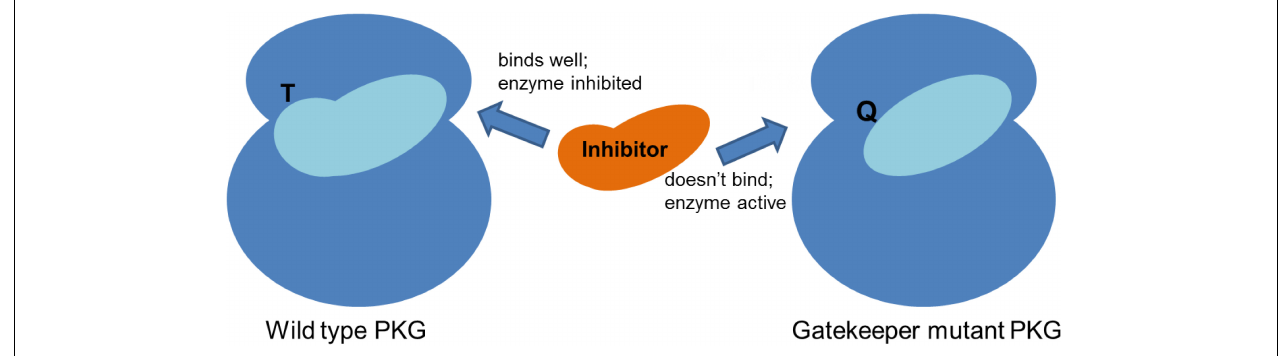
FIGURE 2 | Schematic showing that inhibitors bind effectively to the malaria parasite PKG due to the presence of a small gatekeeper residue (threonine, T), which upon mutation to a bulkier residue (glutamine, Q), prevents inhibitor binding.